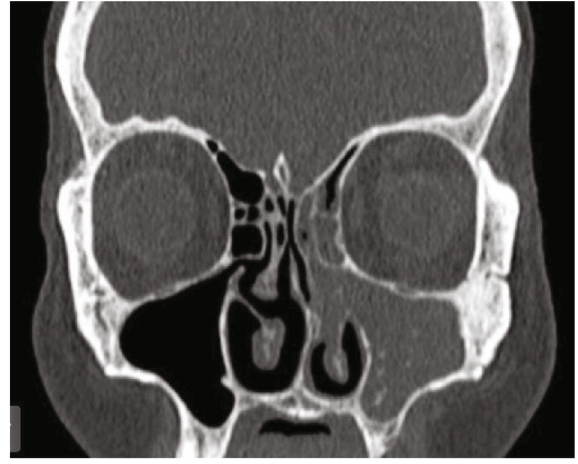
Figure 2: Frontal CT section showing the fi lling of the left maxillary